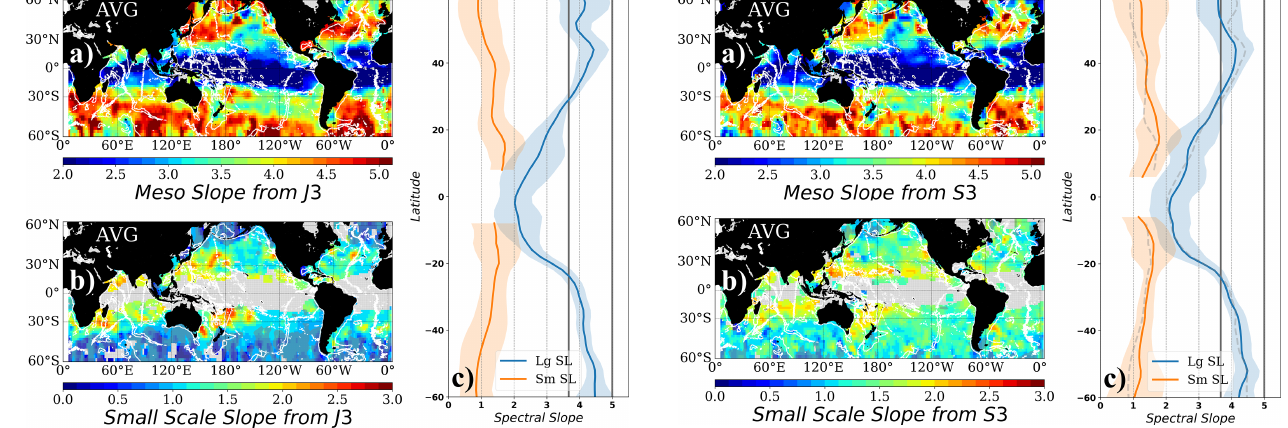
Figure 4. (a) Mesoscale and (b) small-scale spectral slopes fitted to the observed unbiased PSD from Jason-3. (c) Zonal average of the mesoscale (Lg SL) and small-scale (Sm SL) spectral slopes in (a) and (b) . Color shading around the average values corresponds to the 95% confidence interval for the zonal mean. Vertical gray lines denote the k − 11 / 3 and k − 5 spectral slope values. Gray shading in (b) corresponds to zones where the uncertainty associated with the slope estimate is higher than 40% of the slope value. Blanks zones in (b) correspond to zones where the double-slope model does not describe the observed shape of the spectrum. White contours represent the topography at 3000m depth.